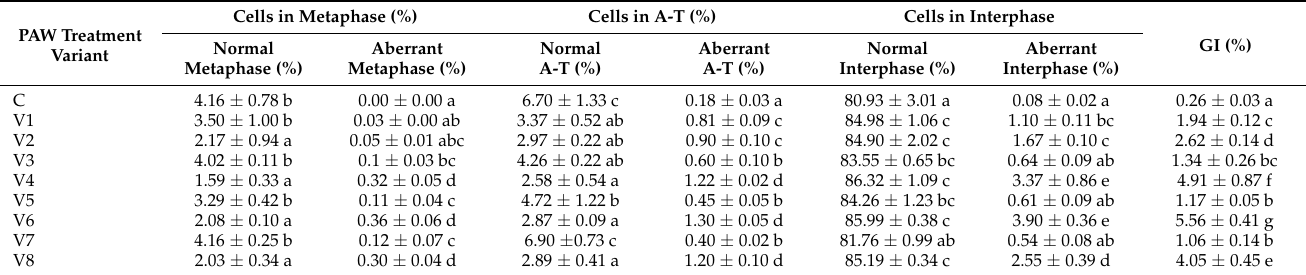
Table 3. Frequency of genetic abnormalities in mitotic phases on the root tips of Triticum aestivum treated with non-thermal plasma-activated water